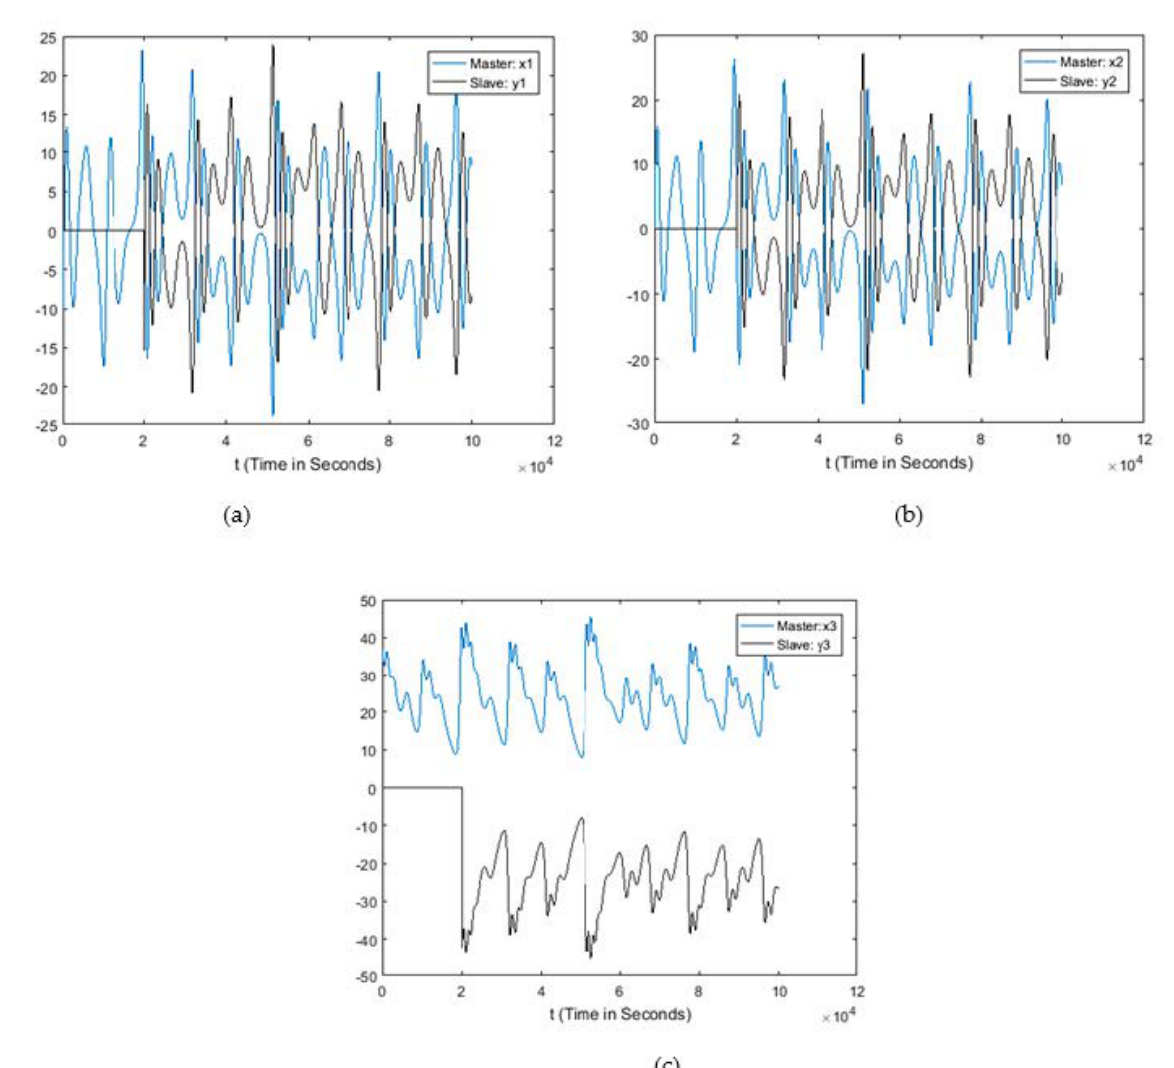
Figure 7. Time response ( a )–( c ) of synchronized states of master and slave.